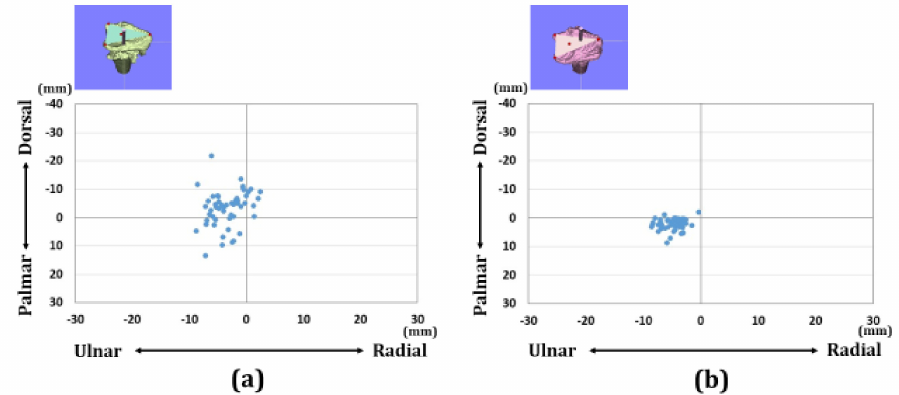
Figure 7. Results of barycentric coordinates of the three reference points in the axial plane. ( a ) Results of barycentric coordinates for the preoperative image. ( b ) Results of barycentric coordinates for the postoperative image.